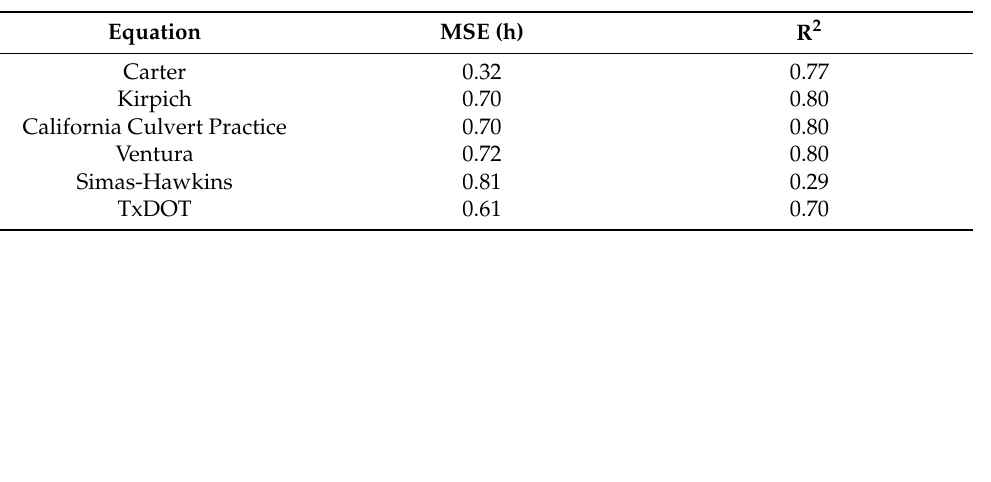
Table 7. Determination of MSE and R 2